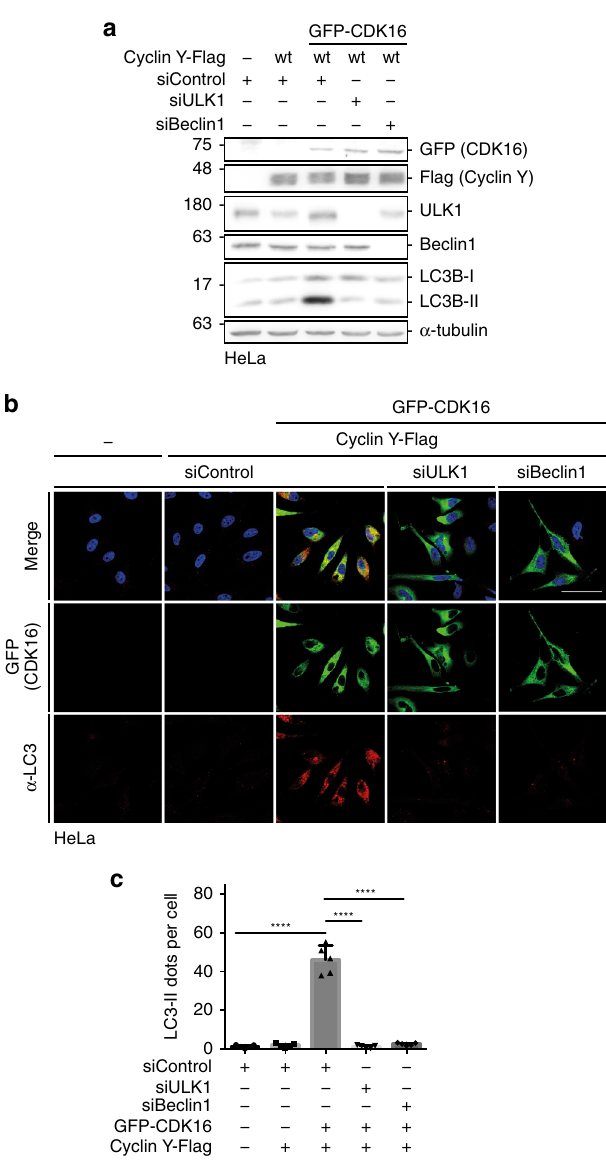
Fig. 5 ULK1 and Beclin1 are required for Cyclin Y/CDK16-induced autophagy. a HeLa cells were co-transfected with siRNA against ULK1, Beclin1 or a control and vectors expressing GFP-CDK16 and Cyclin Y-Flag for 72 h. Lysates were immunoblotted with the indicated antibodies. ( n = 3). b Representative confocal images of HeLa cells treated as in panel a . GFP-CDK16 identi fi ed transfected cells. Endogenous LC3 staining (red) with the 4E12 antibody monitored autophagy. Scale bar: 50 µ m. c Quanti fi cation of the LC3 dots shown in panel b . Statistical signi fi cance was measured via unpaired and two-tailed Student ’ s t -tests and is presented as follows: **** p < 0.0001. All error bars indicate SD. ( n = 1; 250 cells were analyzed for each treatment; siControl vs. siControl Cyclin Y/ CDK16: t = 13.49, df = 8; siControl Cyclin Y/CDK16 vs. siULK1 Cyclin Y/ CDK16: t = 13.53, df = 8; siControl Cyclin Y/CDK16 vs. siBeclin1 Cyclin Y/ CDK16: t = 13.15, df = 8). n biological independent replicate. SD standard deviation. Source data are provided as a Source Data fi